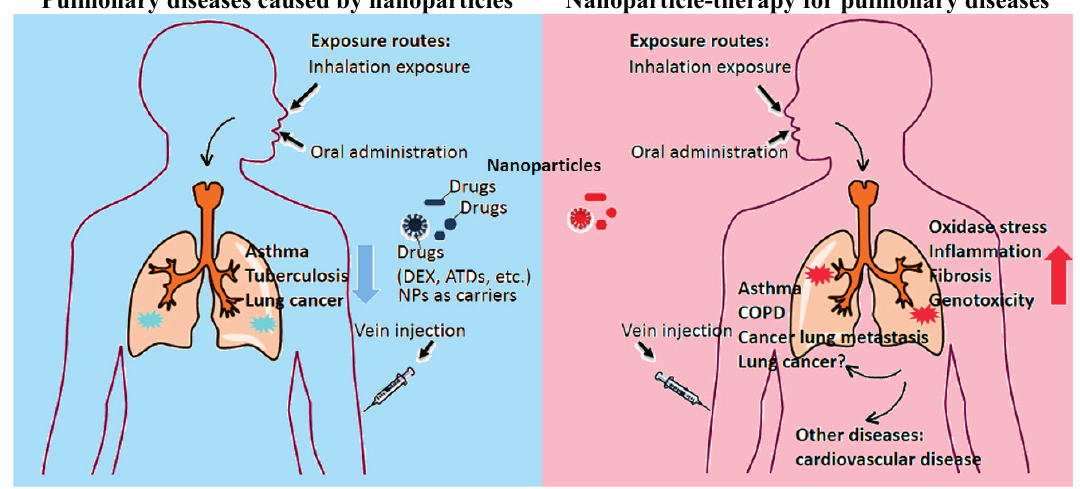
Figure 5. The role of nanoparticles in pulmonary